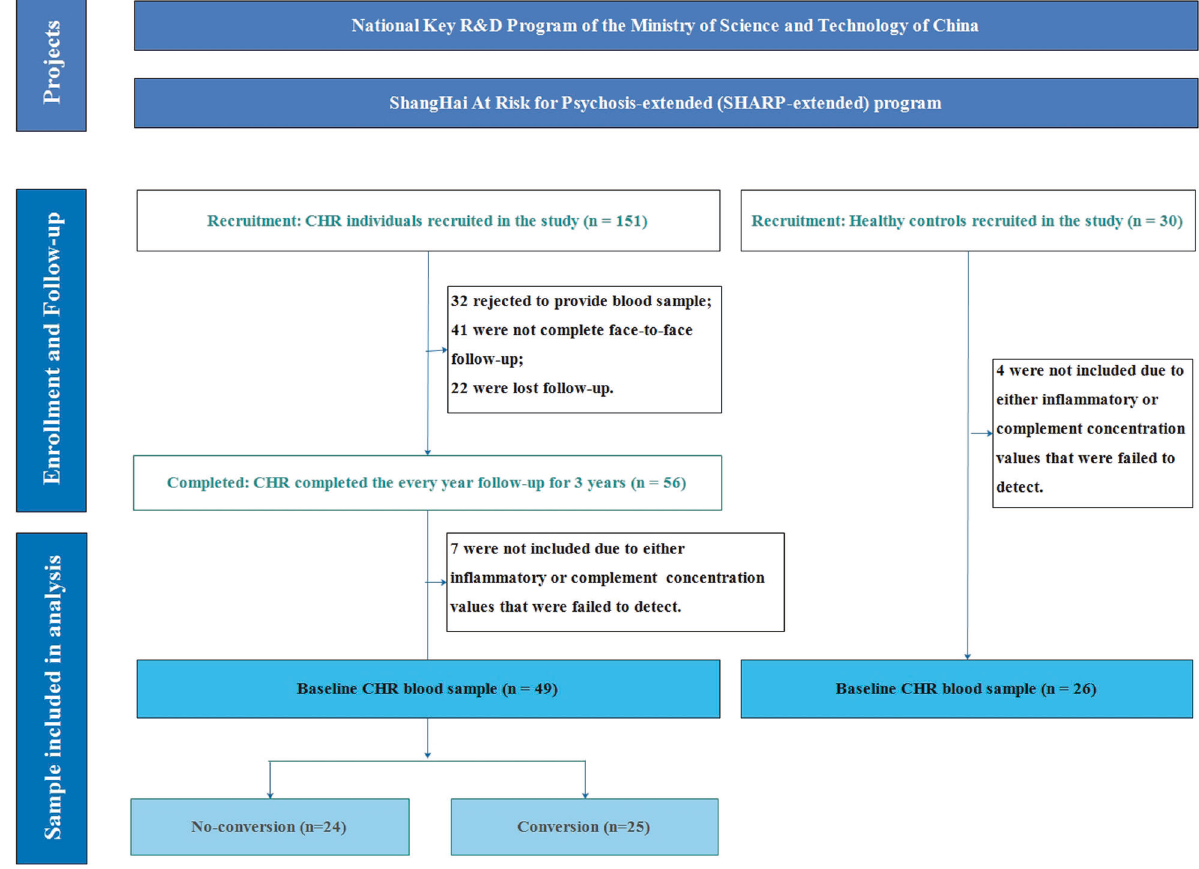
Fig. 1 Sample fl owchart. CHR Clinical high risk for psychosis, CHR-converter CHR individuals who were converted to full psychosis, HC Healthy